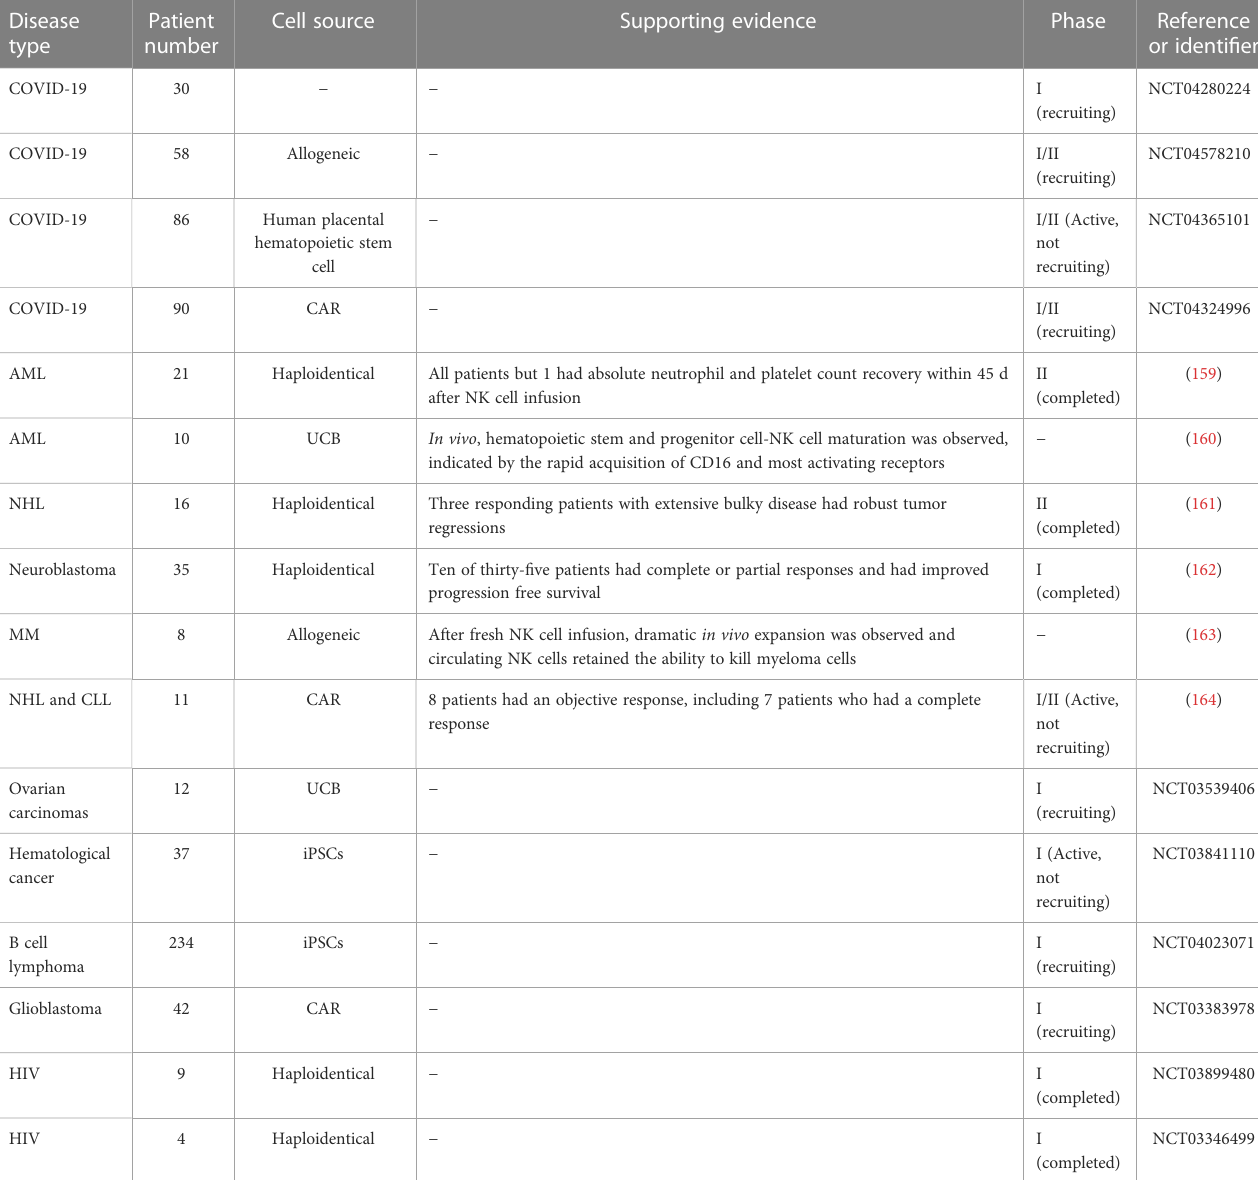
TABLE 3 Summary of the clinical trials on NK cell-based immunotherapy. Disease